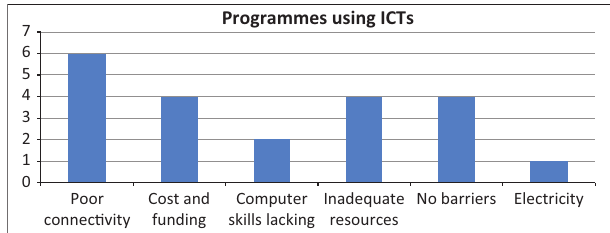
FIGURE 4: Benefits of employing information and communication technology tools in HIV/AIDS management programmes ( N =